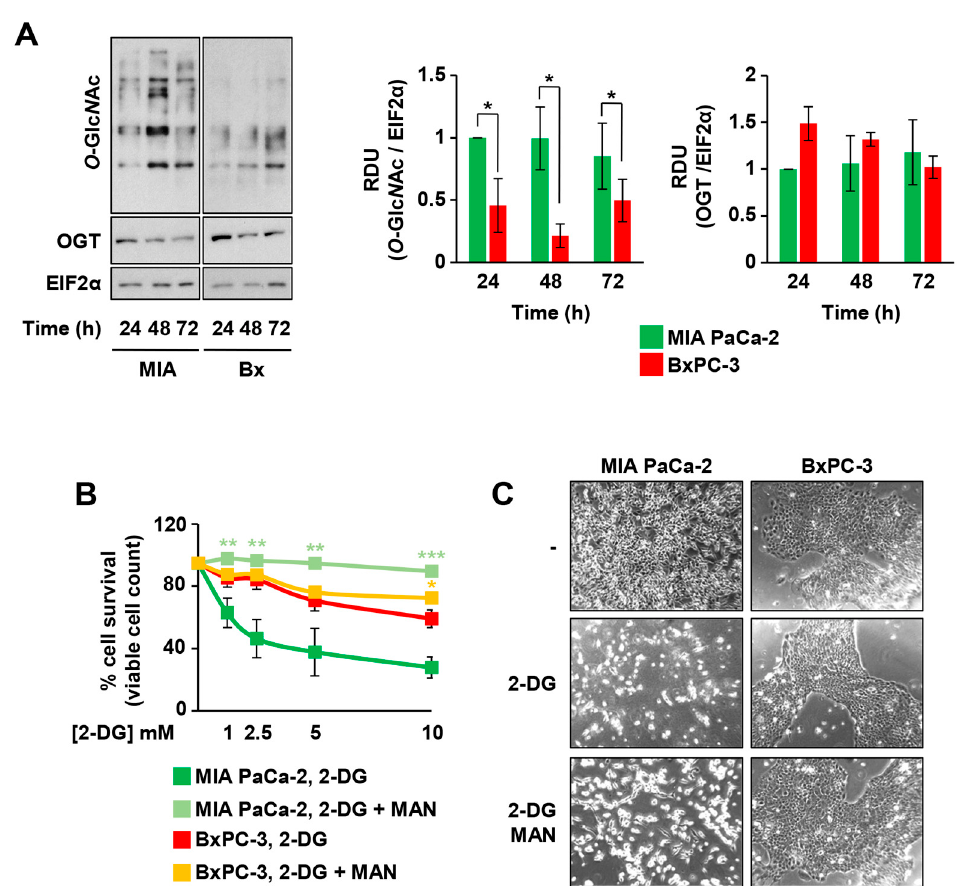
Figure 2. KRASmut MIA PaCa-2 cells are more dependent on the hexosamine biosynthetic pathway (HBP) and glycosylation for their survival than KRASwt BxPC-3. ( A ) Protein O -Glc N Ac and OGT expression were detected in total cell extracts from MIA PaCa-2 and BxPC-3 cells at 24, 48, and 72 h of culture. The expression of EIF2 α was used for signal normalization. On the left, a representative image is shown, while the band intensity quantification of at least three independent blots is displayed in the histograms on the right. ( B ) MIA PaCa-2 and BxPC-3 cells were cultured in presence of different concentrations of 2-DG − /+ 1 mM mannose (MAN) and counted after 72 h using the Trypan Blue stain. ( C ) Representative microscopy images of MIA PaCa-2 and BxPC-3 cells upon 72 h-treatment with 2.5 mM 2-DG − /+ 1 mM MAN. All data represent the mean ± SEM of at least three independent experiments. * p < 0.05, ** p < 0.01 and *** p < 0.001 (Student’s t -test), − MAN vs. +MAN in panel ( B